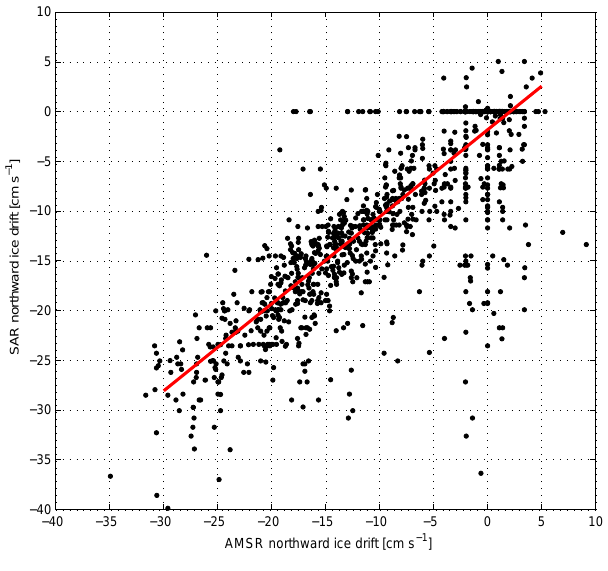
Fig. 5. Comparison between southward ice drift speeds across 79 ◦ N in the Fram Strait from SAR and AMSR data. The data covers winters (October through April) between 2004 and 2010. Individual values are estimated 3-days drift velocities for a given longitude bin. Red line is a linear fit.